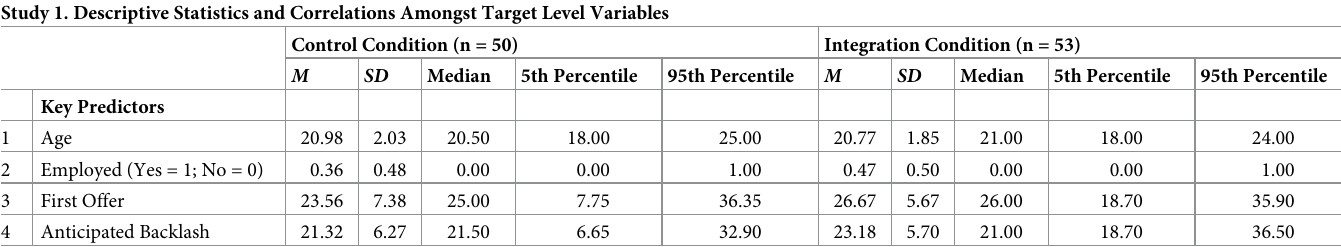
Table 1. Descriptive statistics for key variables in Study